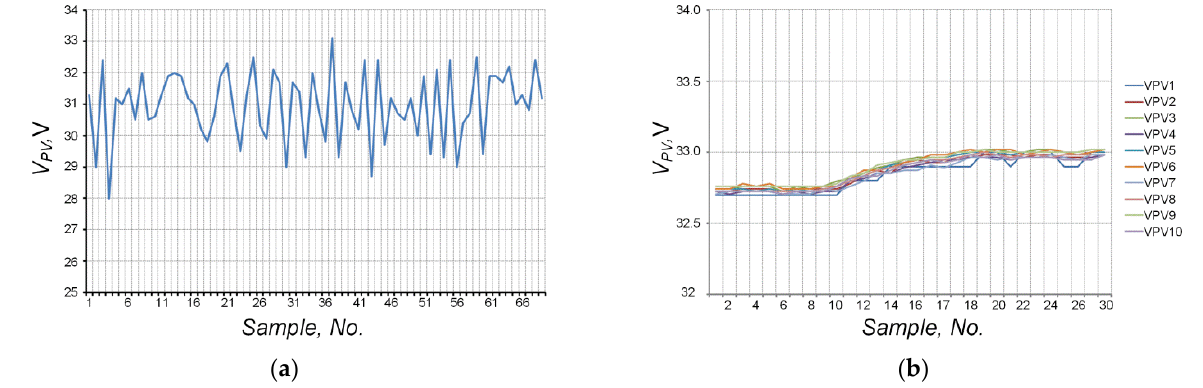
Figure 15. V PV vs. sample No. of PV module loaded by Skymax inverter: ( a ) nominal operation of inverter with active MPPT function in short period of time; ( b ) voltage at PV module terminals measured by test RFID sensors.